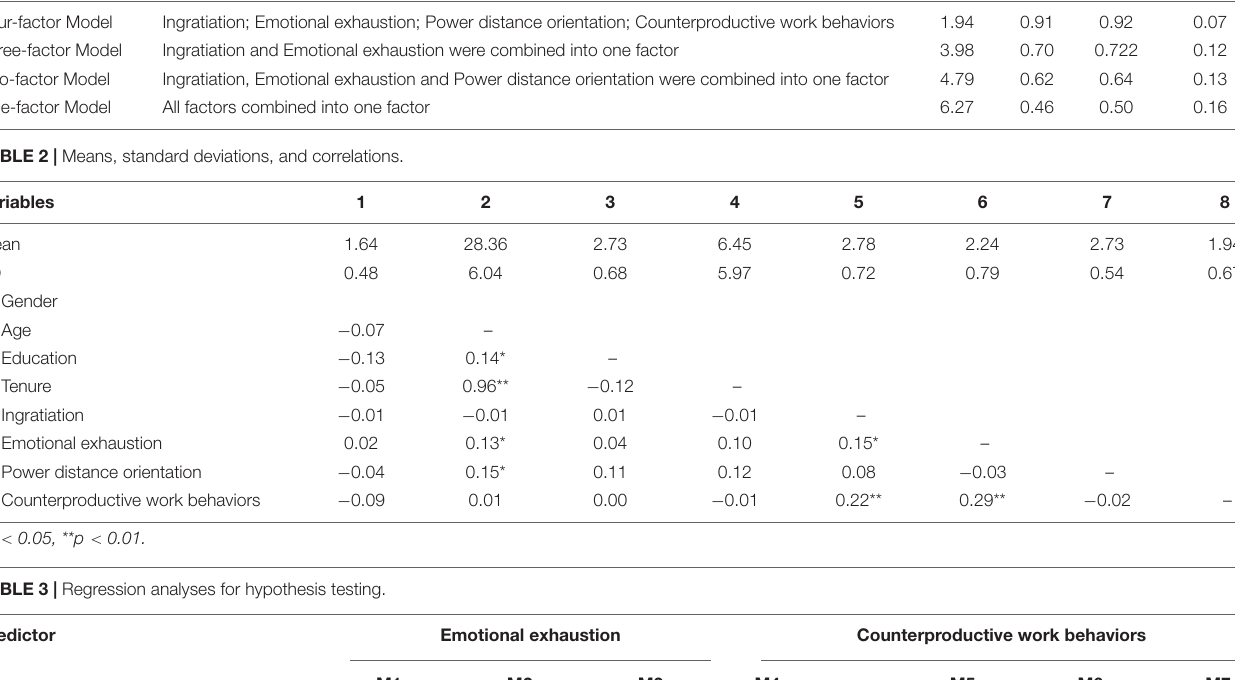
TABLE 1 | Results of confirmatory factor analysis.